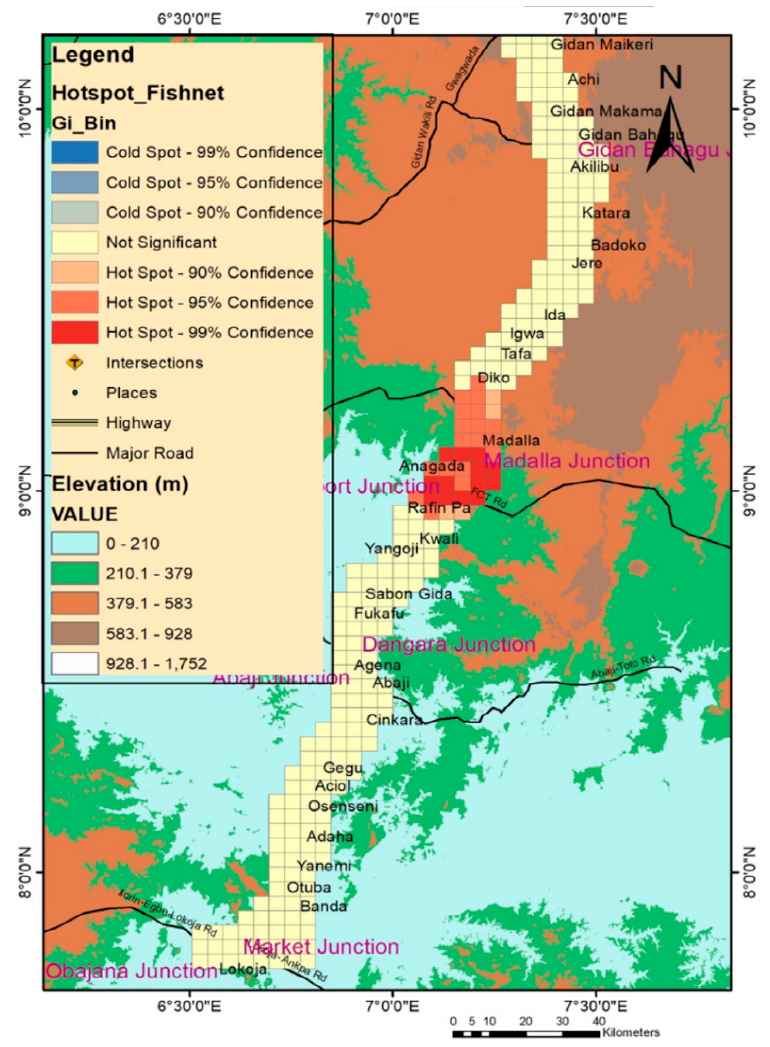
Figure 4. Accident hotspot map of the study route using a fishnet polygon bounded by the highway buffer polygon.